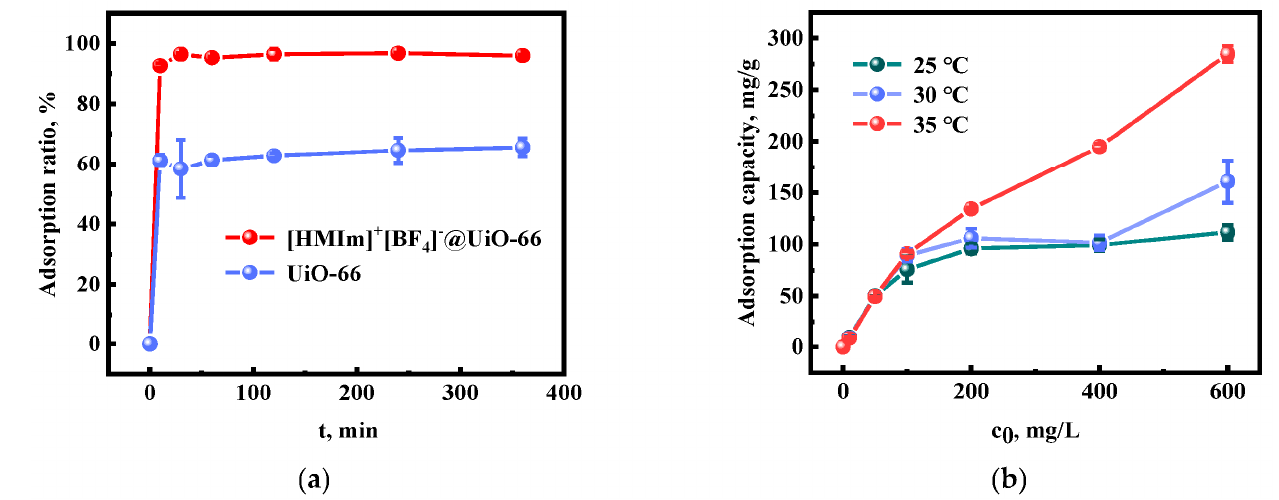
Figure 7. ( a ) Effect of adsorption time; ( b ) effect of the initial Au(III) concentration on the adsorption capacity of [HMIm] + [BF 4 ] − @UiO − 66.